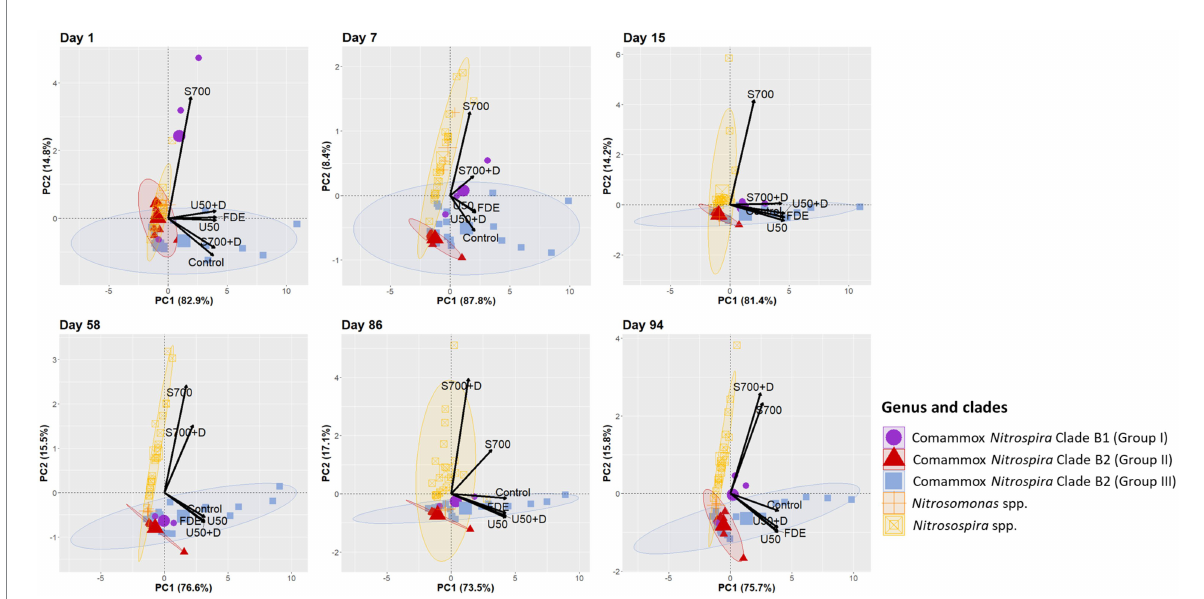
FIGURE 7 Principal Component Analysis of all ASVs correspond to different treatments. PCA plot based on the relative abundance of ammonia oxidizers Nitrosospira spp., Nitrosomonas spp., and comammox Nitrospira Clade B1 and B2 on Day 1, 7, 15, 58, 86, and 94. Relative abundance of each ASV was calculated by dividing the absolute number of each ASV from the total number of clean paired-end sequenced reads from Illumina sequencing. Ellipses around each ammonia oxidizers group are drawn at 95% confidence